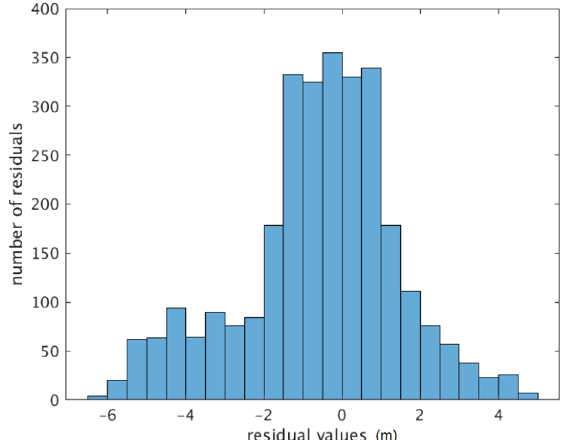
Figure 16. The histogram of the residuals of the 2nd order model after the fit to the absolute residuals.